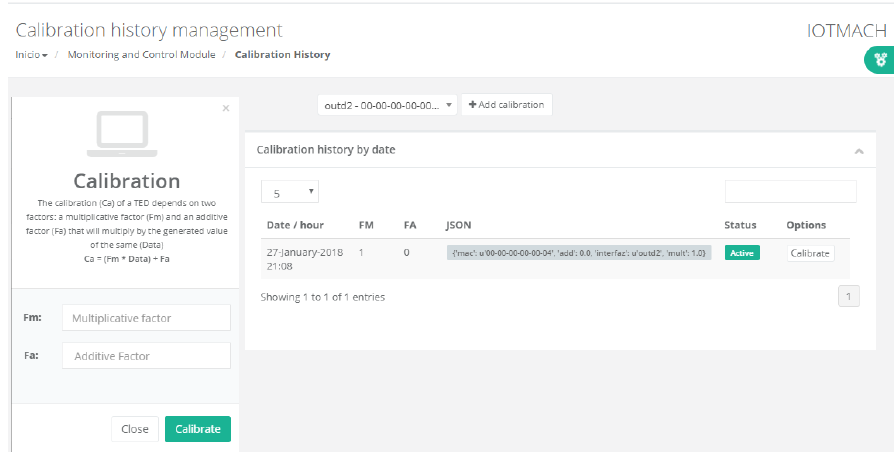
Figure 19. Measurement unit menu.